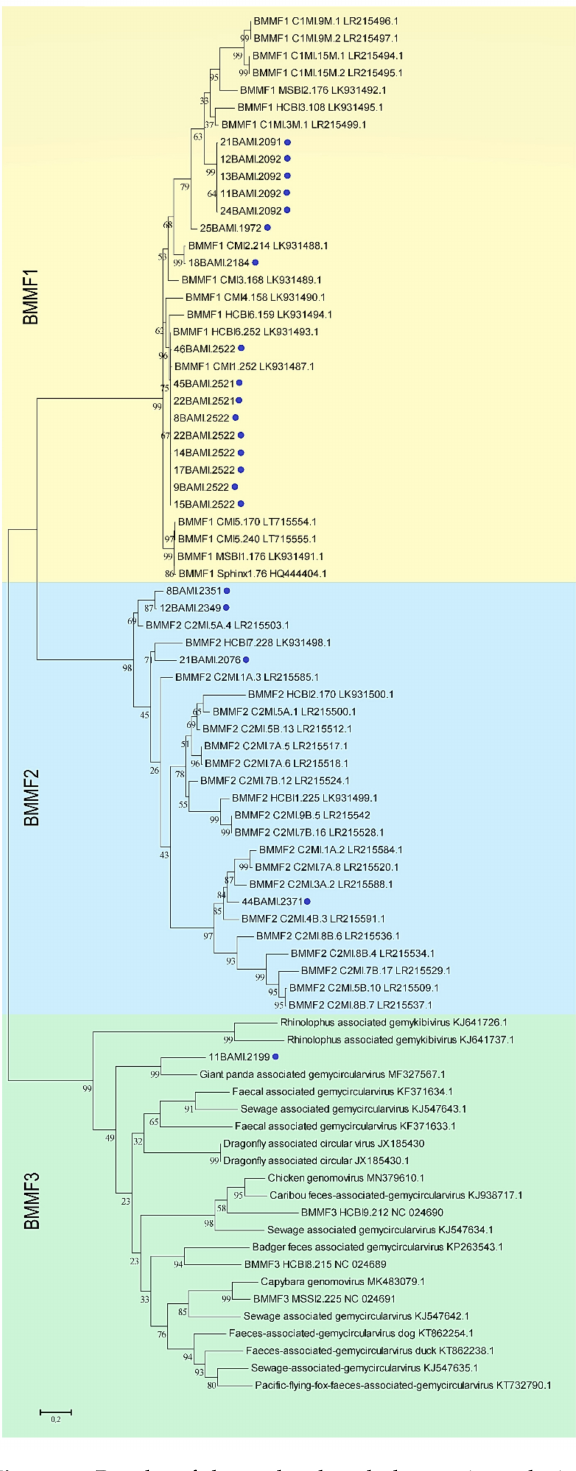
Figure 1. Results of the molecular phylogenetic analysis including novel full-length nucleotide sequences and representatives of the BMMF groups 1 to 3. The latter also includes members of the family Genomoviridae . The evolutionary history was inferred by using the maximum likelihood method and a JTT matrix-based model [34]. The bootstrap consensus tree was calculated from 500 replicates. Bootstrap values at the branch points indicate the percentage of replicate trees in which respective isolates clustered [35]. Branch support values lower than 70% were not included. Blue dots mark all sequences found in this study. The scale bar represents the number of substitutions per site. All taxa are indicated by name followed by the corresponding GenBank accession